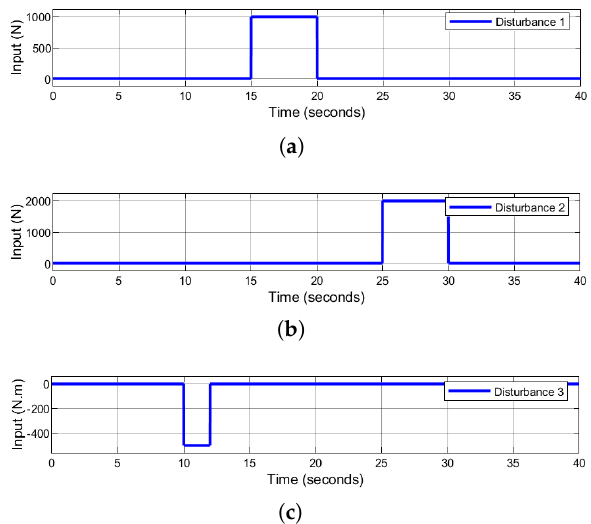
Figure 8. The external disturbances to the crane system. ( a ) The external disturbance on the trolley. ( b ) The external disturbance on the bridge. ( c ) The external disturbance on the pulley.